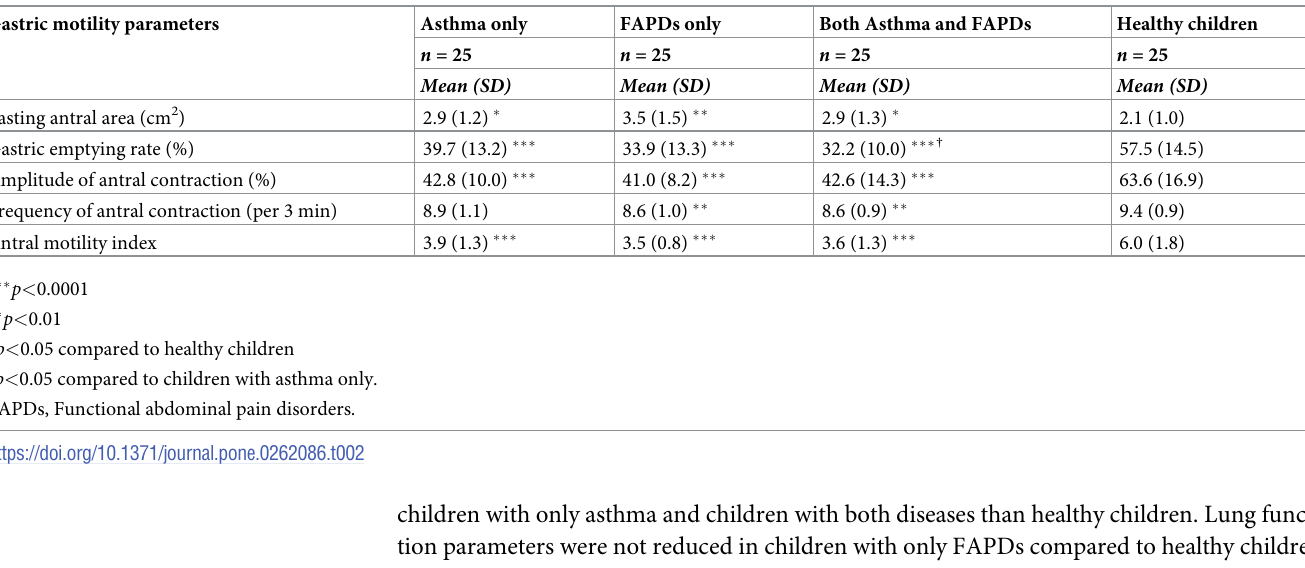
Table 2. Comparison of gastric motility parameters between study groups.